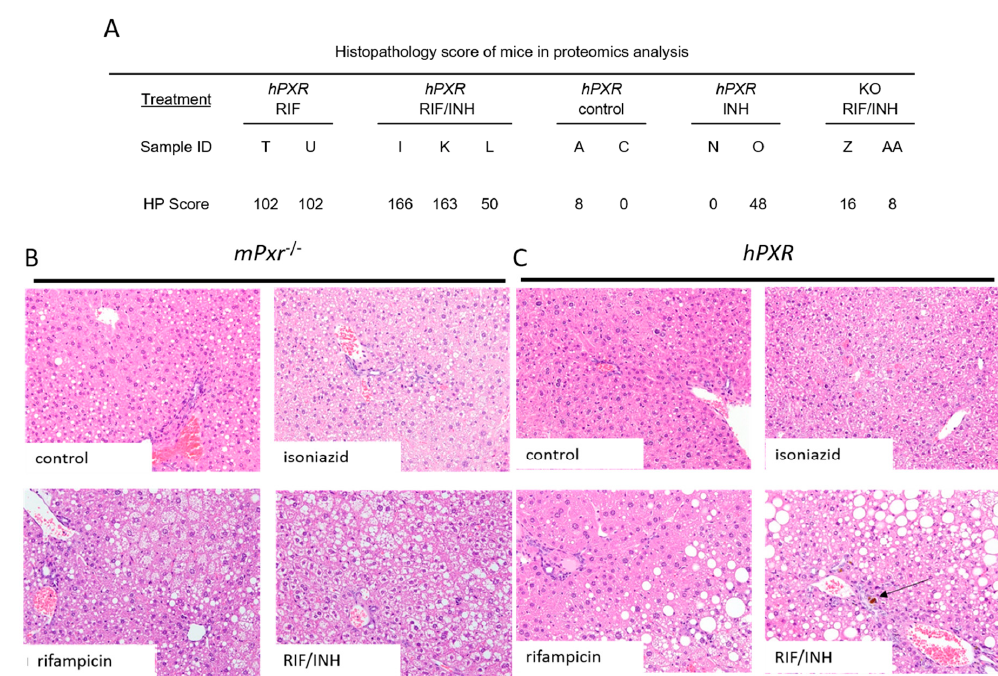
Figure 3. Histopathology of mouse livers. Semiquantitative histopathology scoring was performed by a board-certified veterinary pathologist. ( A ) Total hepatopathology scores (HP) were determined by scoring inflammation, karyomegaly, steatosis, bile pigment, and necrosis. Hematoxylin and eosin staining of hPXR ( B ) and mPxr − / − ( C ) mouse livers (20 × ), arrows indicate bile plugs.